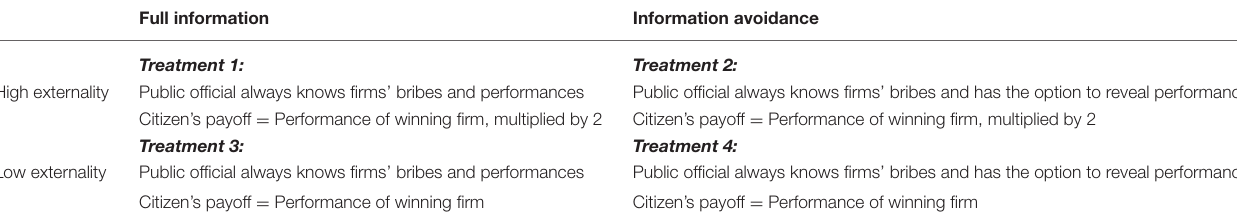
TABLE 1 | Experimental